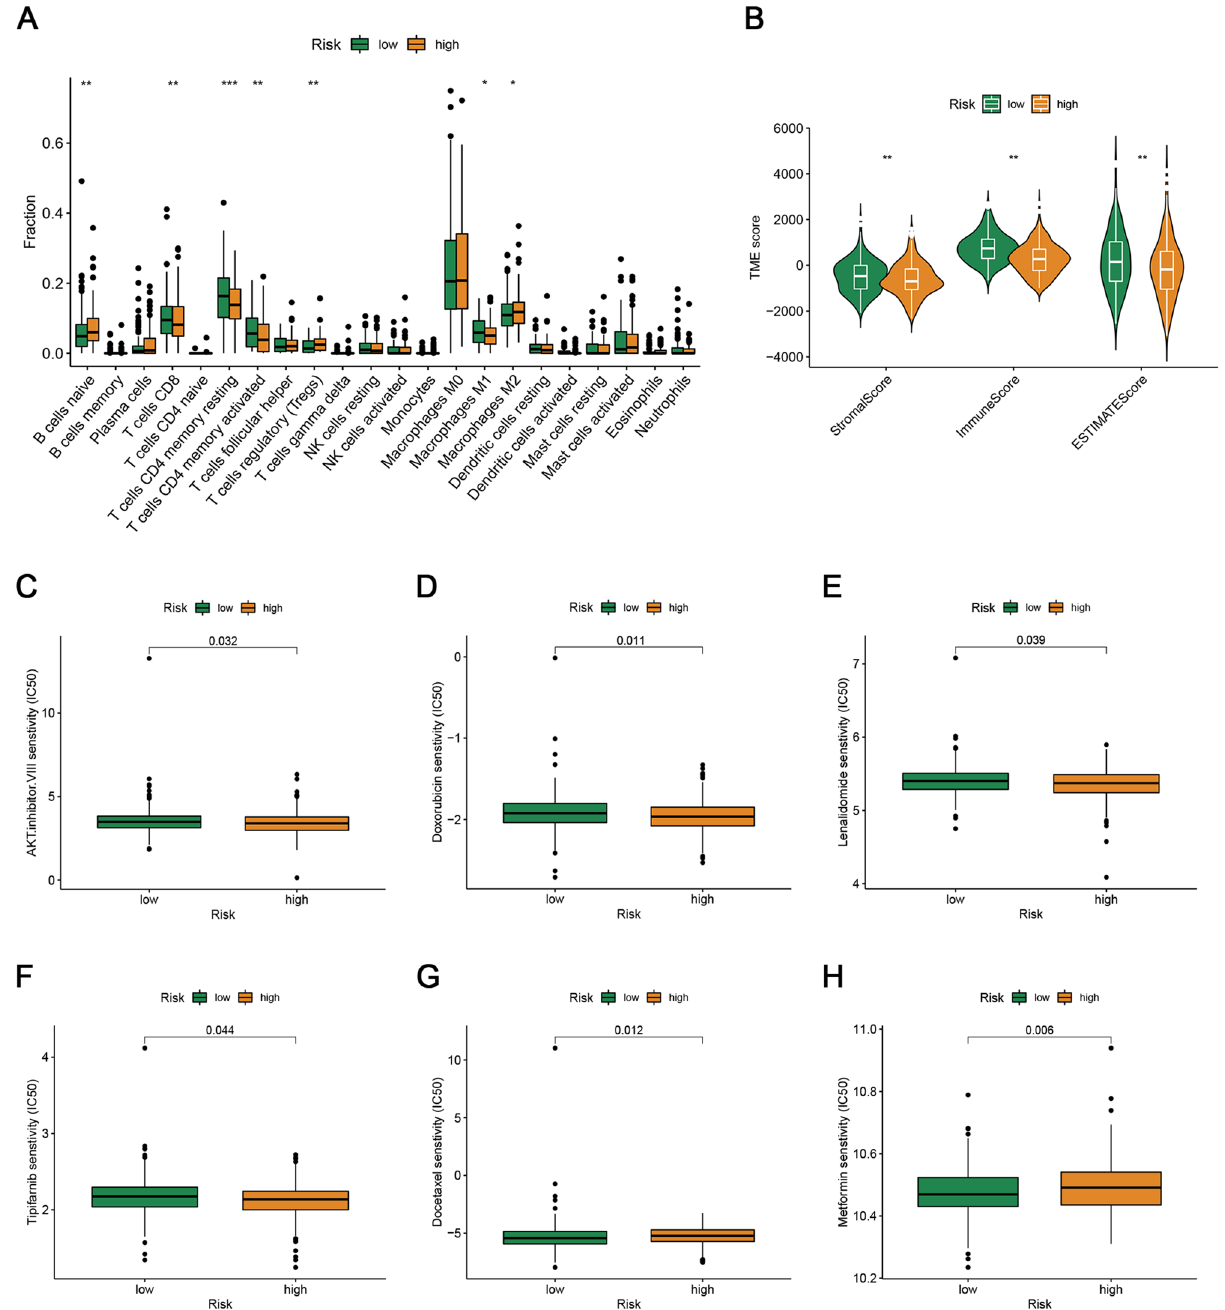
Figure 4. Immune landscape and drug sensitivity analyses between the two risk groups. ( A ) The abundance of infiltrating immune cell types in the low- and high-risk groups. ( B ) The comparison of immune, stromal, and estimate scores between the low- and high-risk score groups. ( C – H ) Estimated IC50 values of chemotherapy and targeted therapy drugs in the high- and low-risk